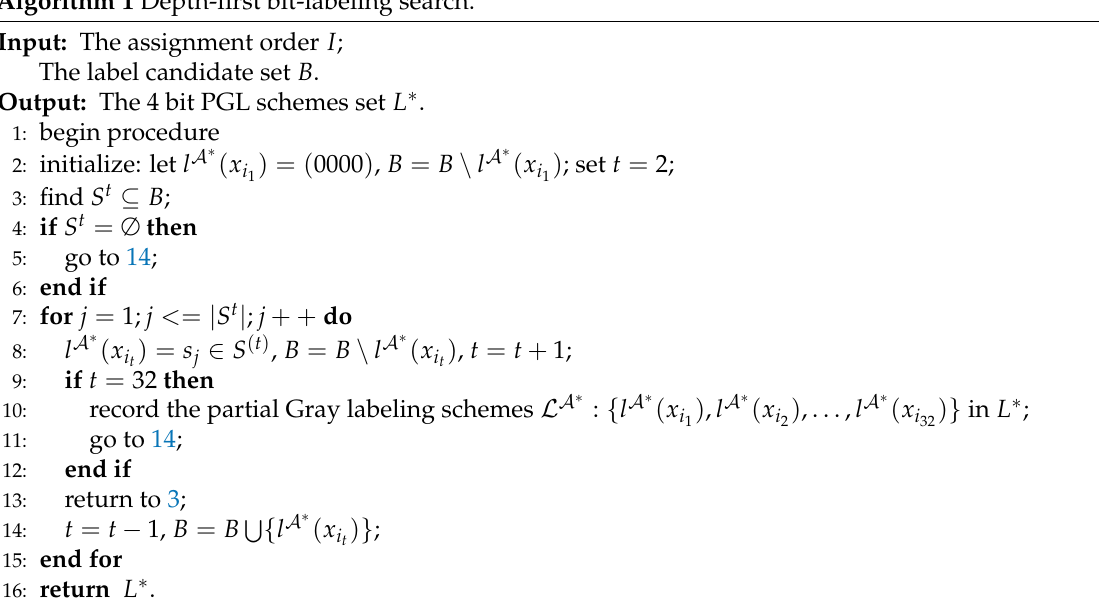
Algorithm 1 Depth-first bit-labeling